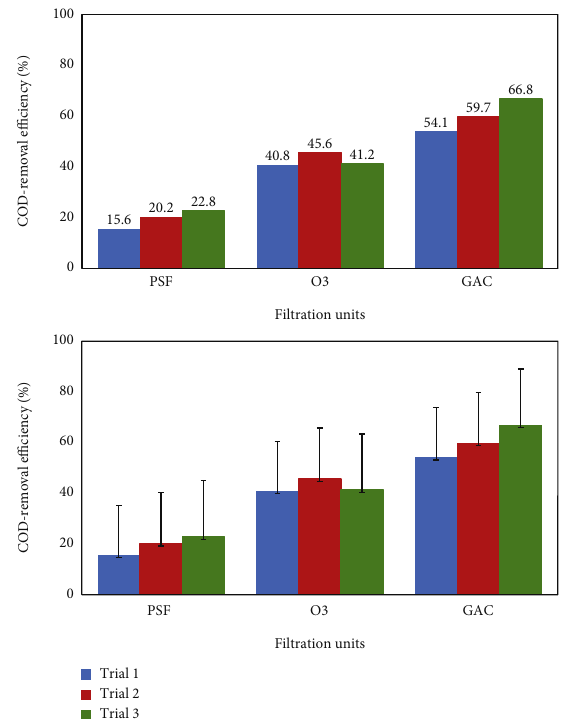
Figure 5: Bar chart representing the removal e ffi ciency of pollutants in PSF, O